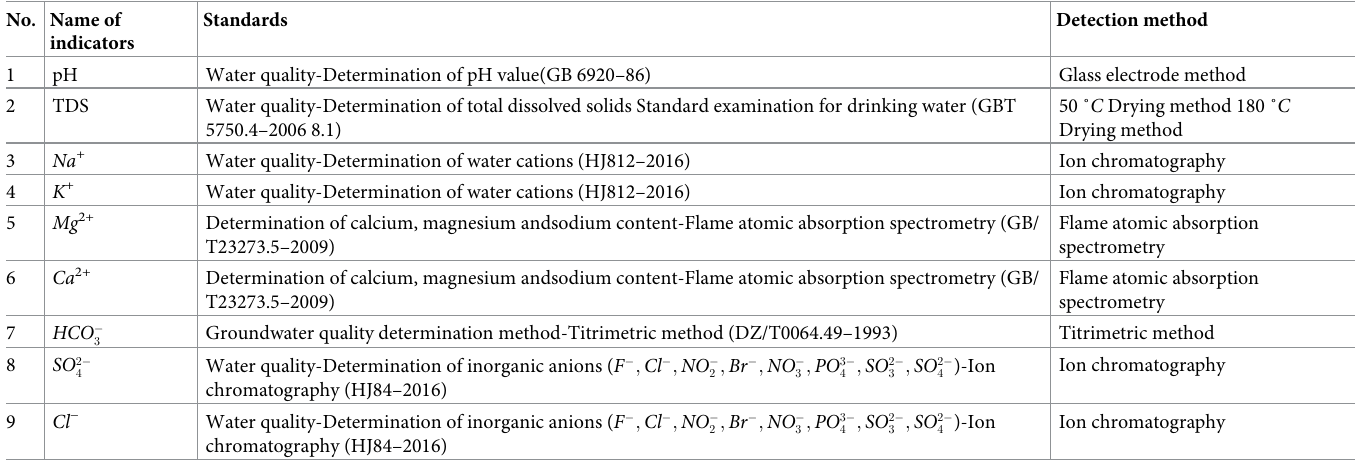
Table 2. Ion concentration detection methods and